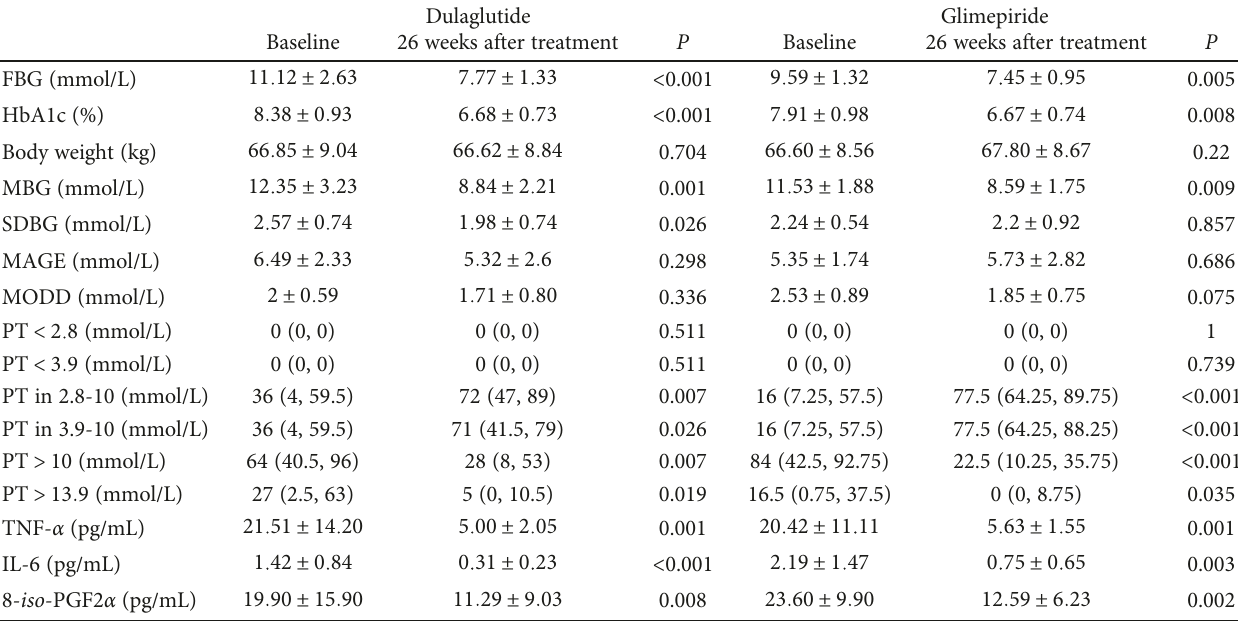
Table 2: Comparison of blood fl uctuation, oxidative stress, and in fl ammatory pro fi le within groups. Dulaglutide Glimepiride Baseline 26 weeks after treatment P